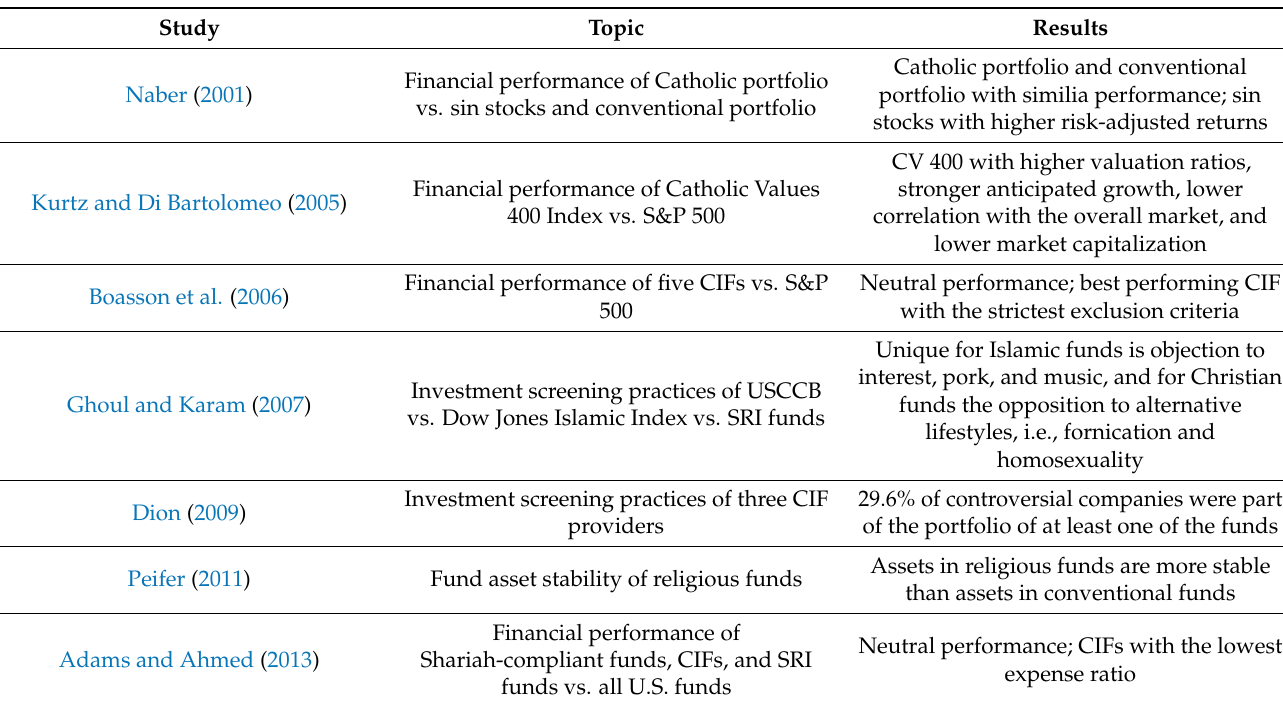
Table 1. Overview of studies addressing